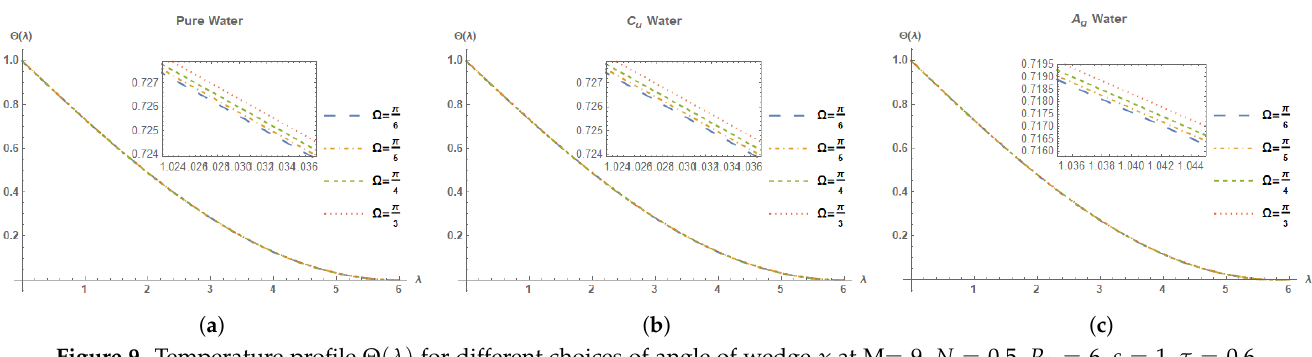
Figure 8. Temperature profile Θ ( λ ) for different choices of heat source/sink parameter ε at M = 9, N = 0.5, P R = 6, χ = π τ = 0.6, η u = 0.1, Γ = 2, ε = 1, C T = 0.1, S = 1 showing their exciting nature. ( a ) pure-water. ( b ) Cu-water. ( c ) Ag-water.